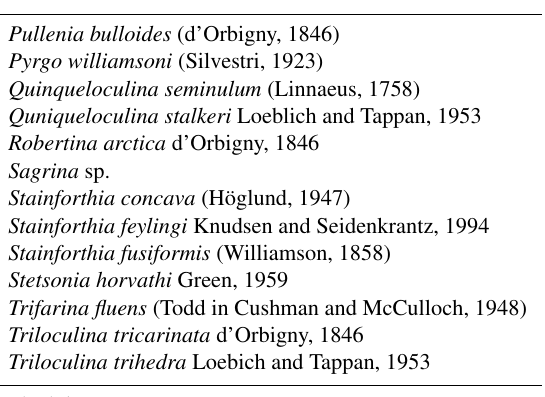
Table A2. Continued.